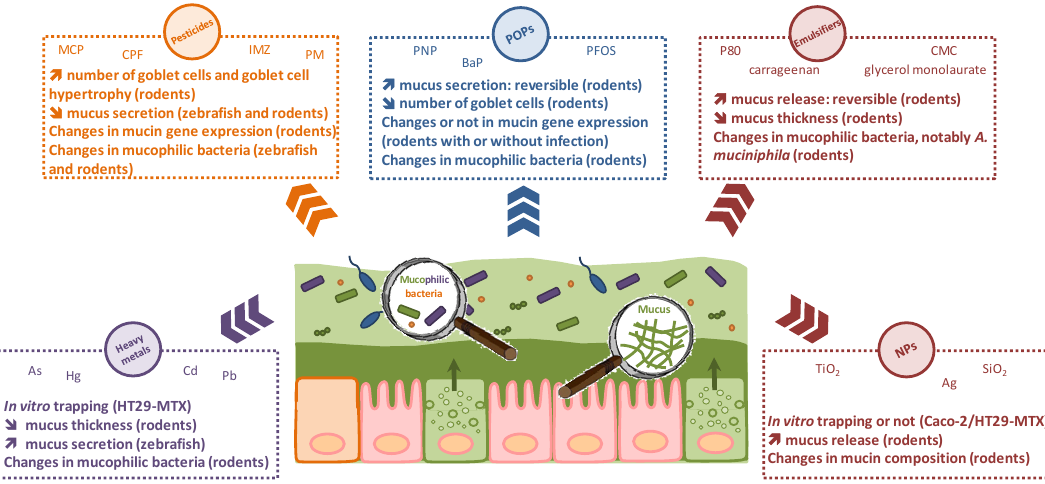
Figure 1. A schematic view of the effects of heavy metals, pesticides, persistent organic pollutants (POPs), emulsifiers, and nanoparticles (NPs) on mucus and mucophilic bacteria in the gut.